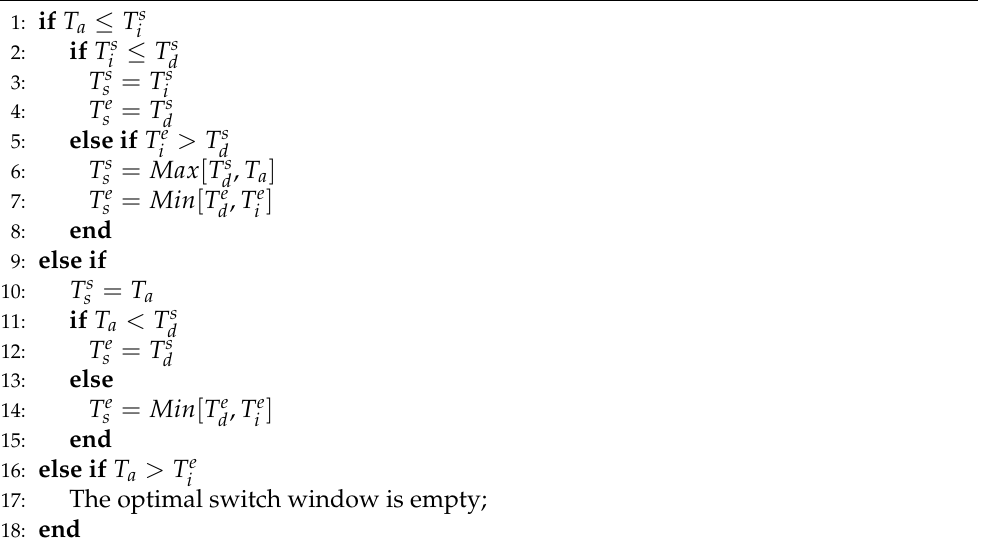
Algorithm 1 Sensor-switching